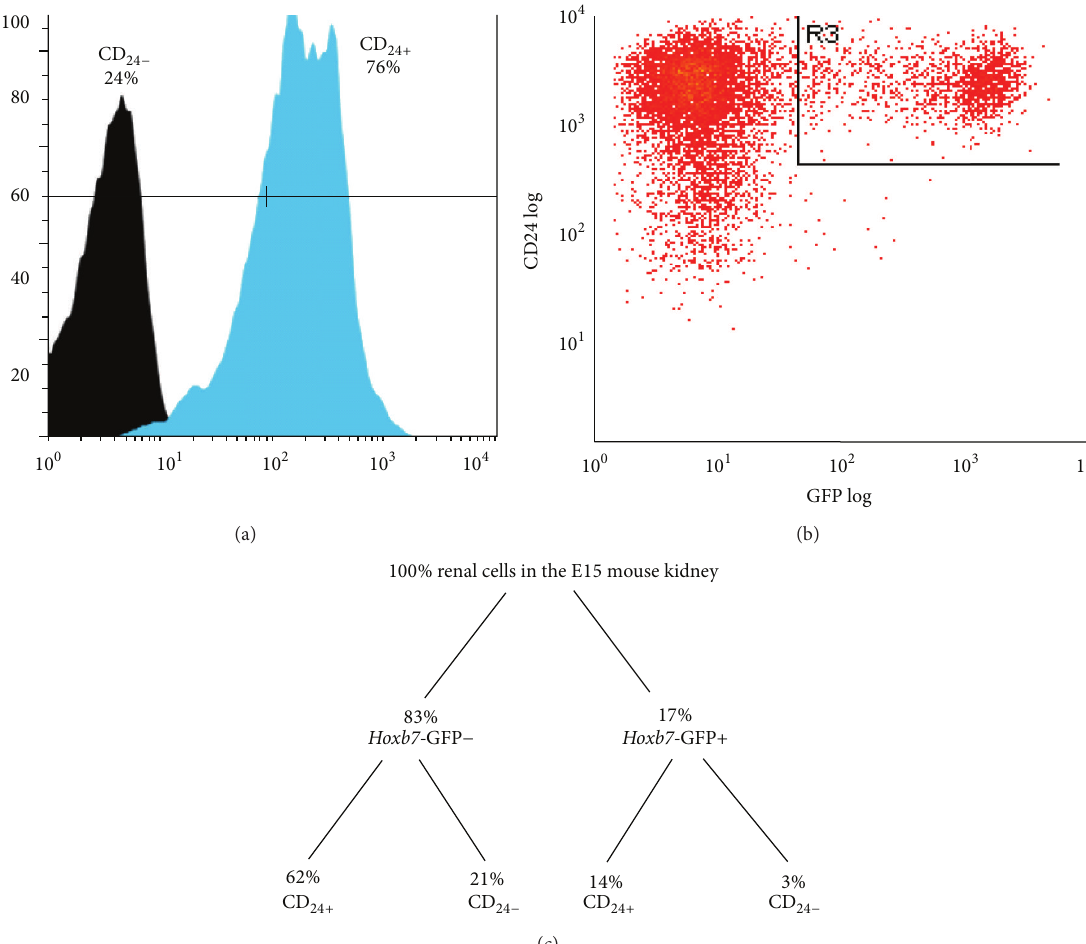
Figure 4: FACS isolation of CD 24+ cells from E15 mouse kidney. Single-cell suspensions were prepared from E15 Hoxb7 -GFP mouse kidneys and analyzed for expression of CD24 and Hoxb7 -GFP by fluorescence-activated cell sorting (FACS). (a) CD 24+ cells represent about 76% of cells in the E15 mouse kidney. (b) 14% of CD 24+ cells coexpress the Hoxb7 -GFP ureteric bud marker. (c) Percentages of E15 mouse kidney cells expressing CD24/ Hoxb7